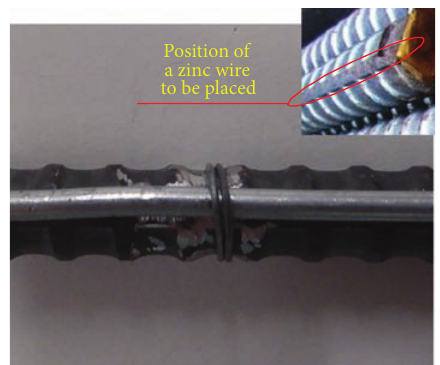
Figure 20: State of a zinc wire bound to steel